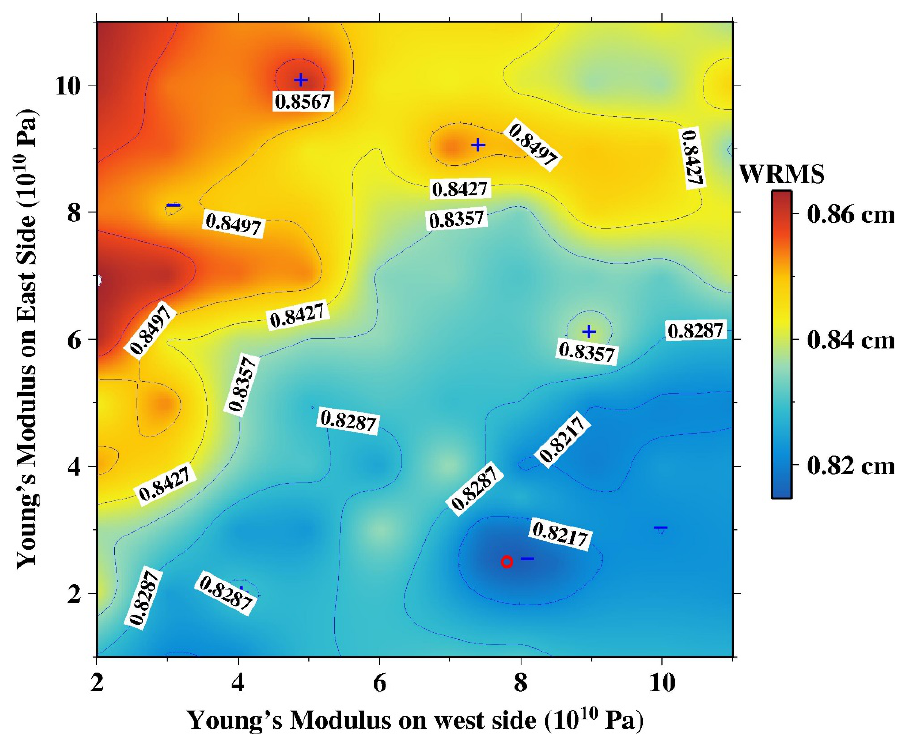
Figure 10. Weighted misfits estimated from the same smoothing factor of κ 2 = 0.05. The red circle represents the smallest weighted misfits.